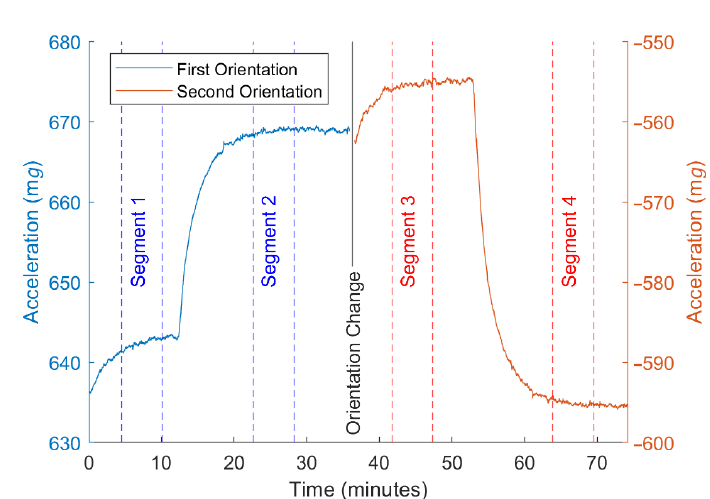
Figure 9. Segments analyzed by the algorithm during the calibration test.